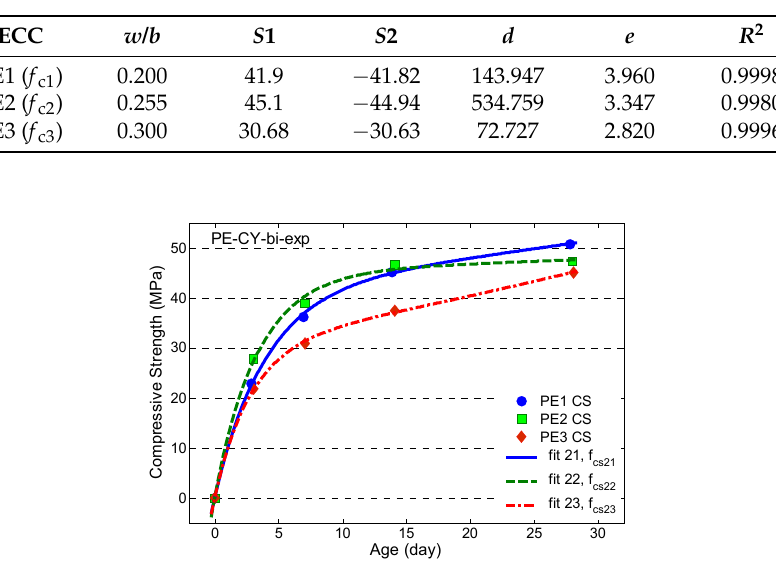
Table 5. Regression coefficients and goodness of fit for Equation (5).